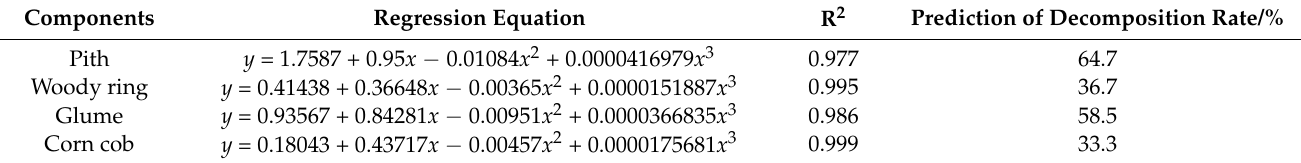
Table 3. Regression analysis of field decomposition of corn